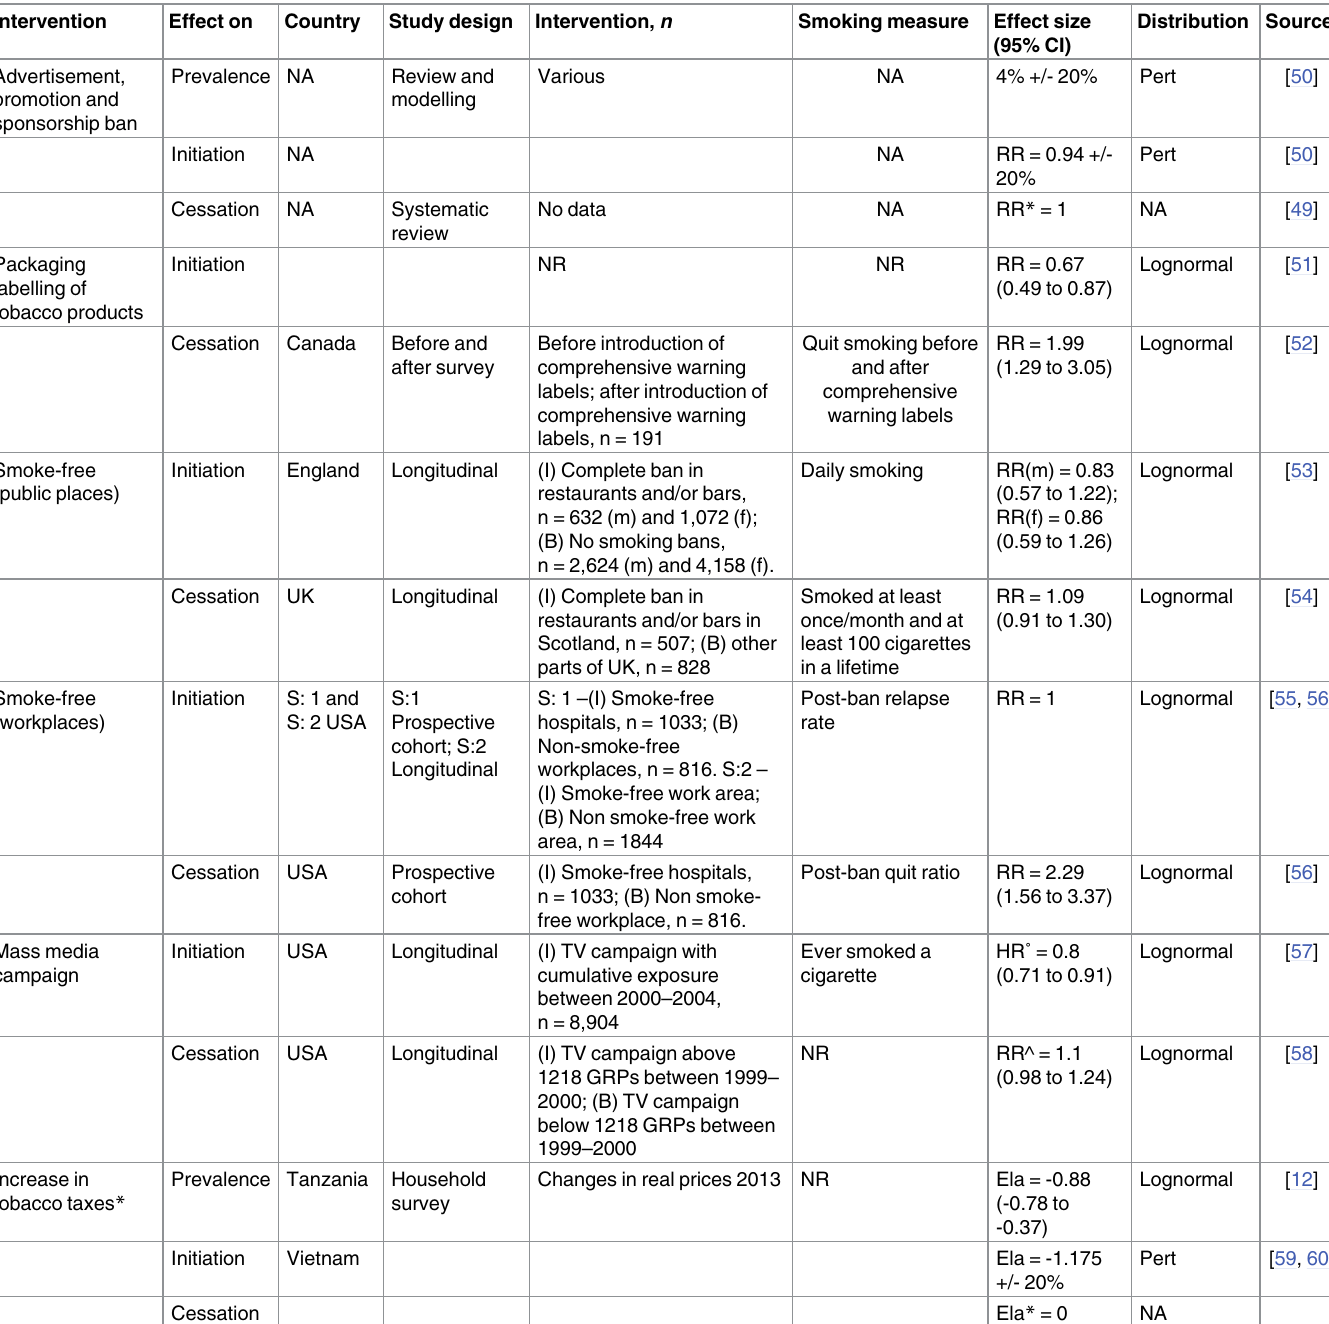
Table 6. Effect size for tobacco control interventions on smoking initiation, cessation and